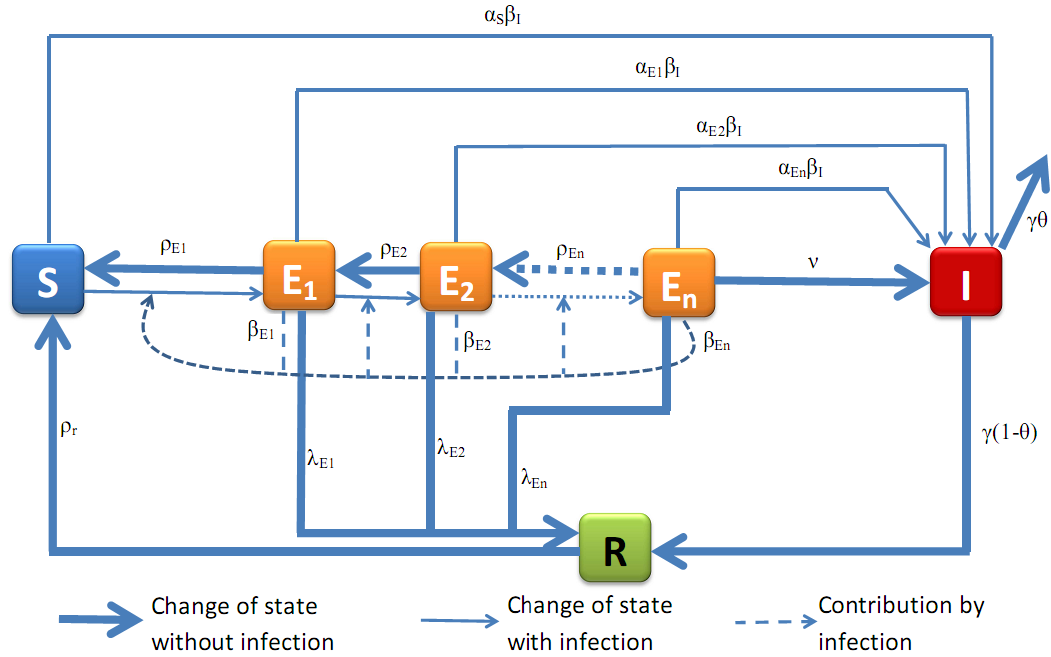
Figure 1. Framework. The nodes with reddish colors (orange and red) represent the compartments of humans that are infectious, while the nodes with greenish colors (black and green) represent the compartments of humans that are not infectious. The various interactions are explained in the descriptions of Equations